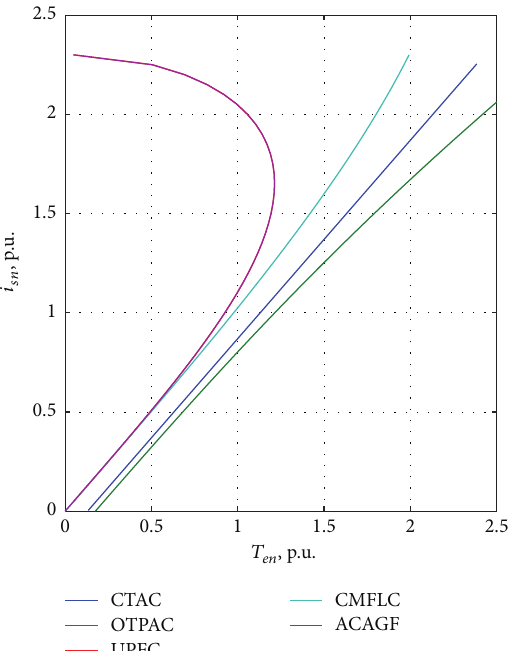
Figure 10: Voltage requirement for five different control strategies as a function of normalized